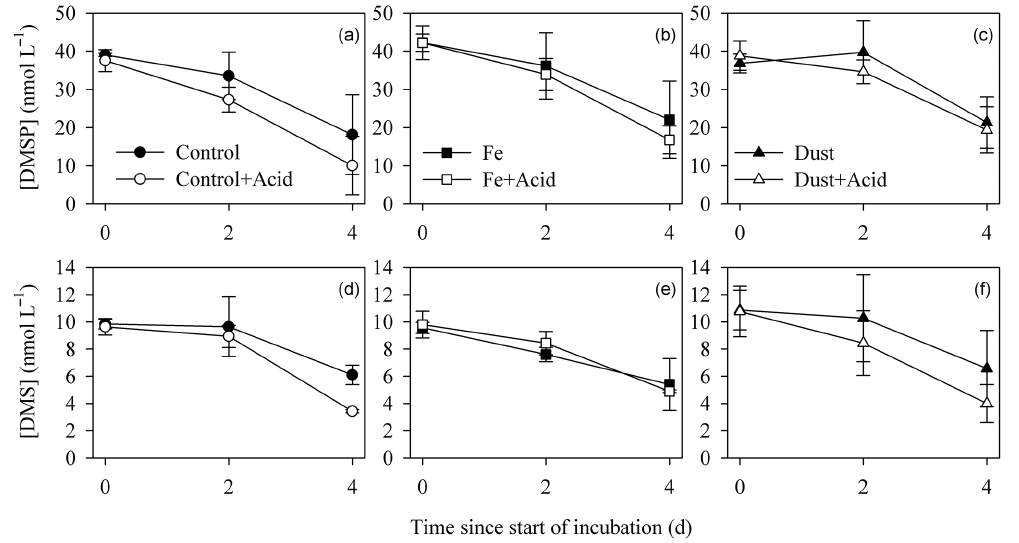
Figure 5. DMSP t (a, b, c) and DMS (d, e, f) concentrations (nmolL − 1 ) in the Control and Control + Acid treatments (a, d) , the Fe and Fe + Acid treatments (b, e) , and the Dust and Dust + Acid treatments (c, f) . Error bars indicate standard deviations. n = 3 except Control, where n =